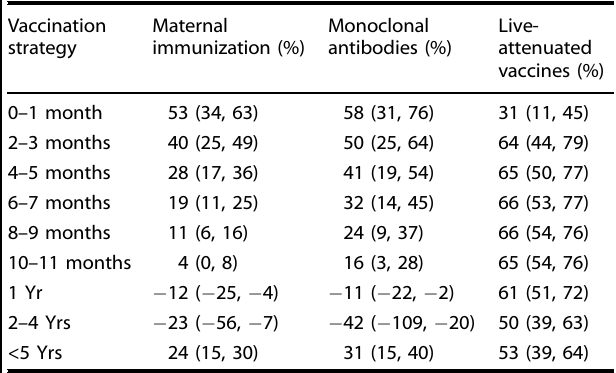
Table 1. Predicted overall vaccine effectiveness. Vaccination strategy